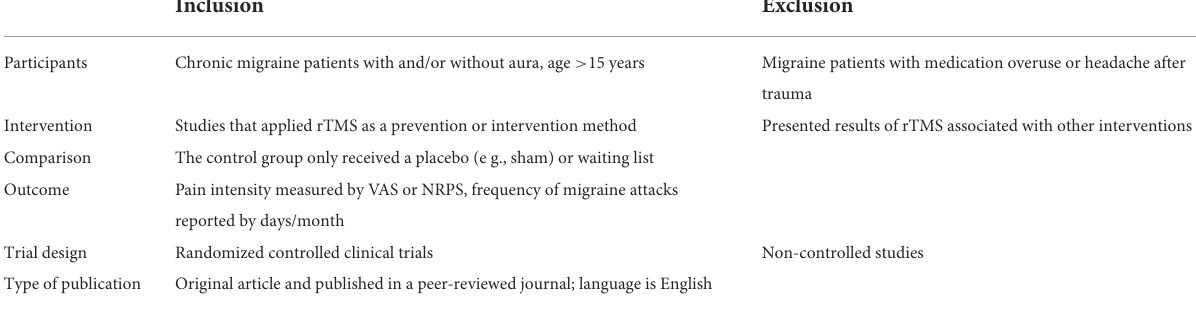
TABLE 1 Eligibility criteria for considering articles for the review.